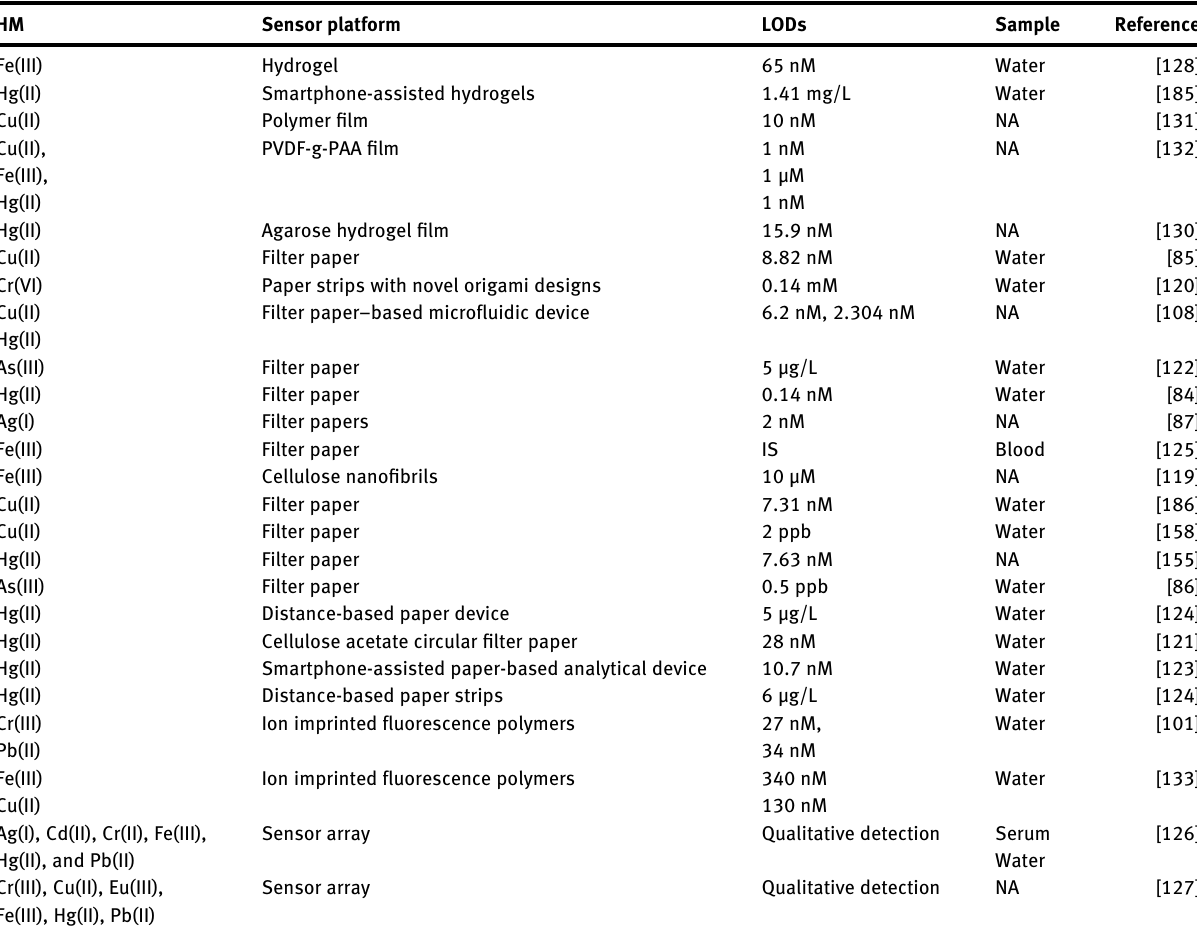
Table  : Summary of solid-state CDs-based fl uorescence sensing